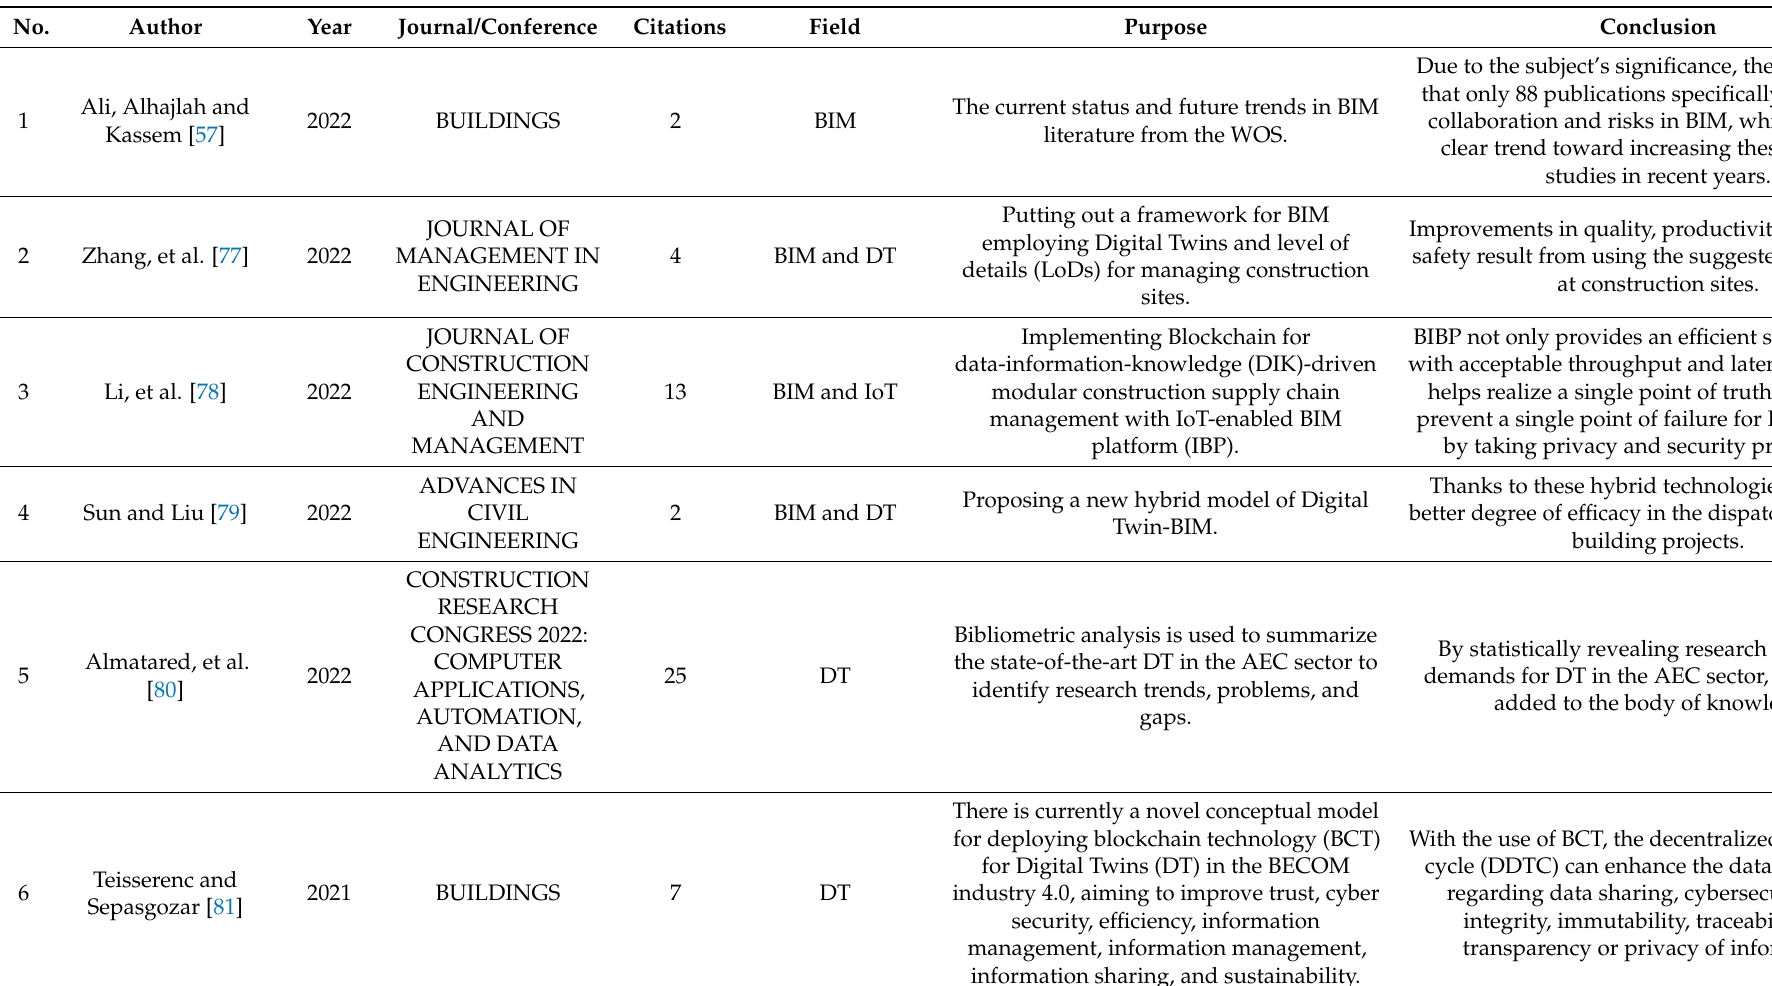
Table 8. A summary of the current papers in the field of BIM, IoT, and DT in